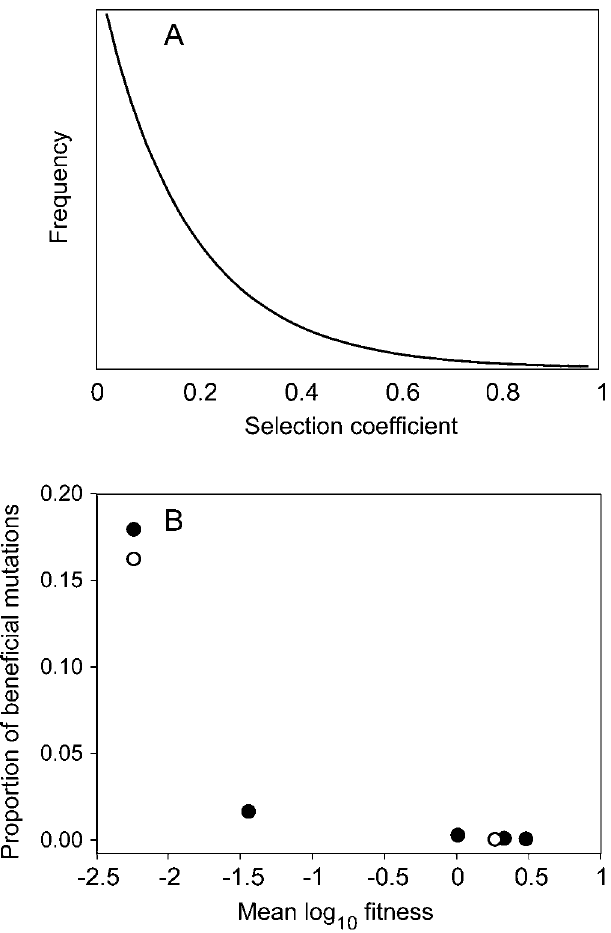
Figure 4. Mutational Parameters (A) Shape of the joint ML gamma distribution of mutational effects for all MA datasets. The distribution is extremely leptokurtic (L-shaped), with the majority of mutations having very small selection coefficients, although a significant proportion have large selection coefficients. (B) Relationship between fitness and rate of compensatory mutation. Filled circles indicate the inferred proportion of compensatory mutations using the ML gamma distribution (illustrated in [A]) and the experimental fitness equilibria (see Materials and Methods). Open circles indicate the ML estimation from the mutation accumulation data. The close match between the two methods suggests that the estimates of B are robust. The two overlapping points have been displaced slightly for clarity. It appears that there is a nonlinear relationship between the proportion of beneficial mutation and log-fitness. This is not the relationship that would be expected under the simplest hypothesis of compensatory mutation (see text for more details).